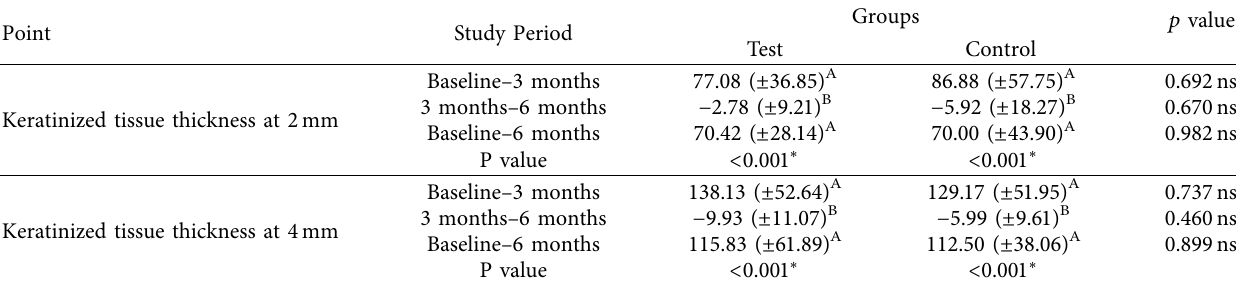
Table 4: Mean and SD values of keratinized tissue thickness (KTT) at 2mm and 4 mm percentage change (%) within each group at different study